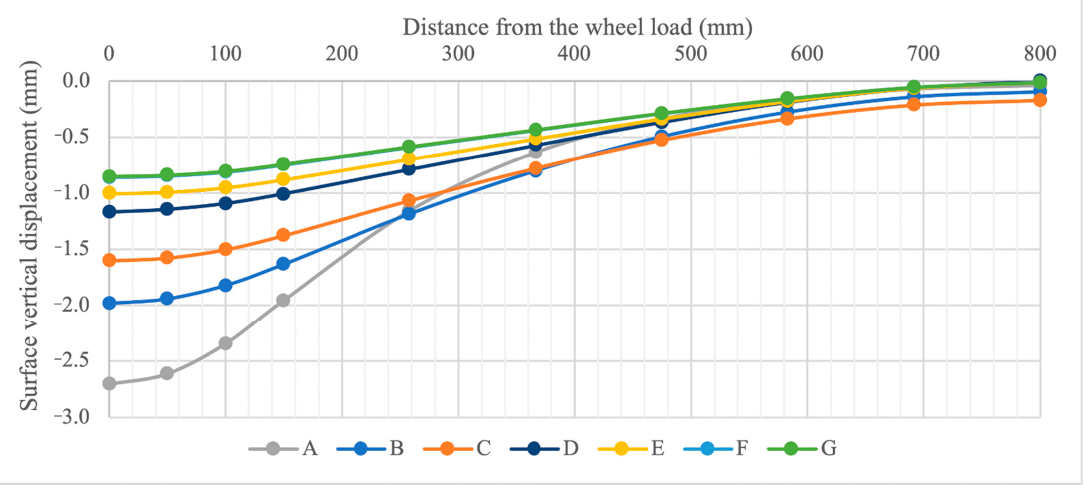
Figure 5. Surface vertical displacement effect due to geo-grid position.